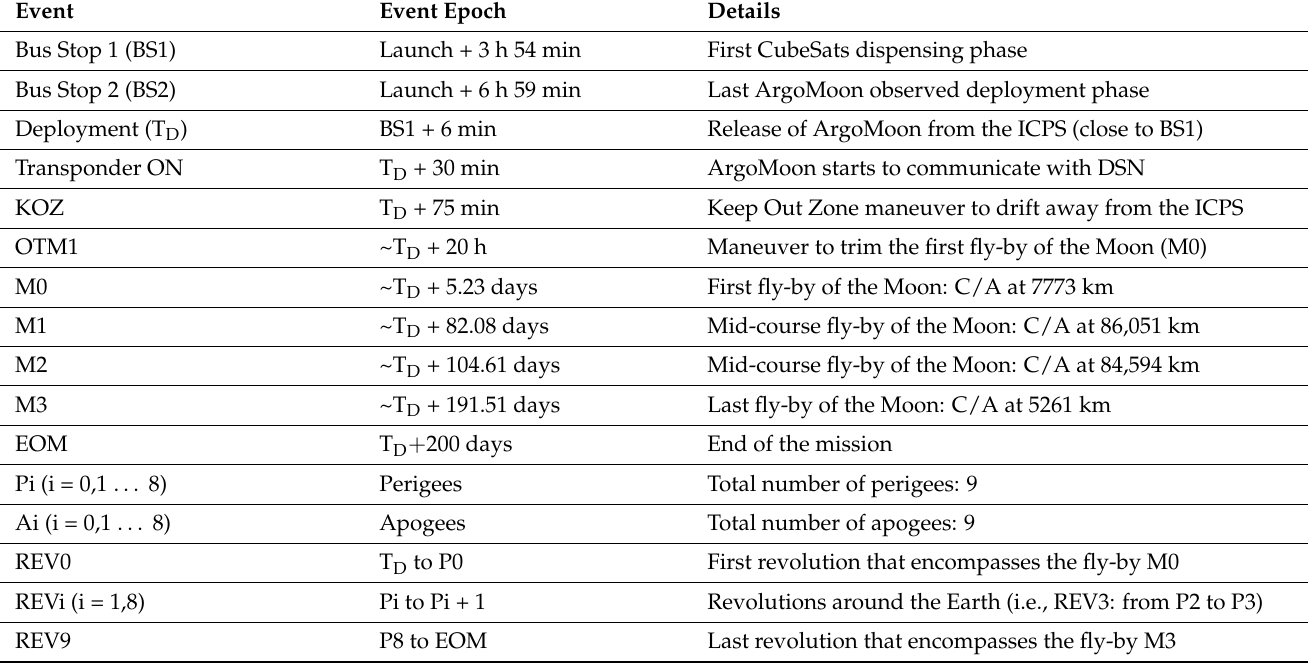
Table 1. ArgoMoon summary mission timeline for the launch date of 6 June